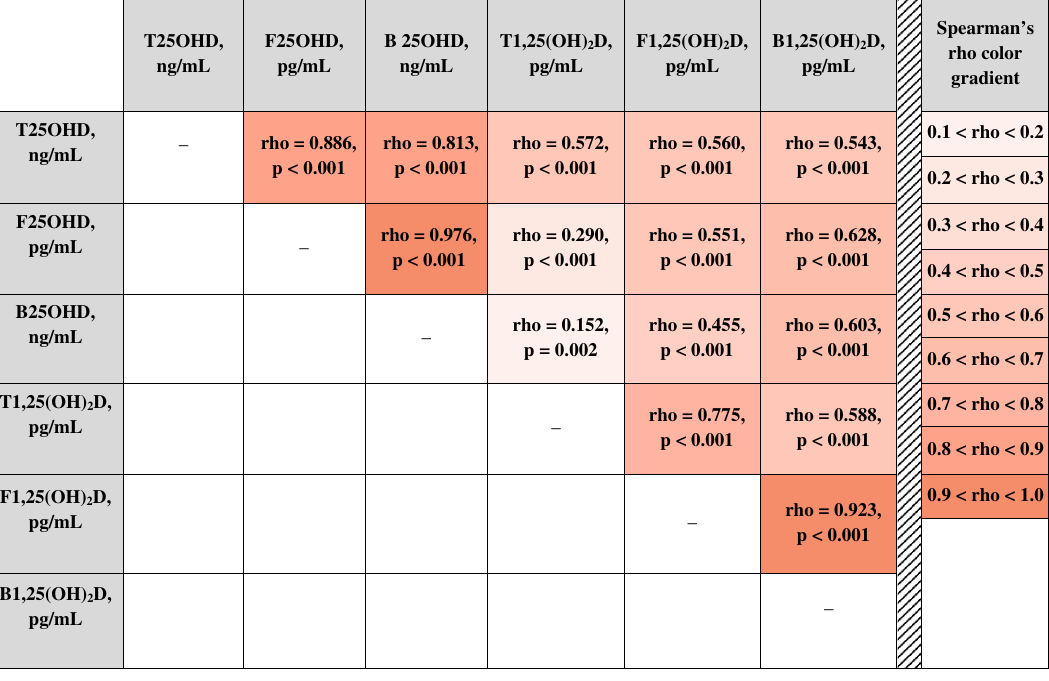
Table 2. Interrelations between 25OHD and 1,25(OH) 2 D isoforms. The correlation strength is defined by Spearman’s rank correlation coefficient rho. Abbreviations: B25OHD, bioavailable 25OHD; B1,25(OH) 2 D, bioavaialble 1,25(OH) 2 D; F25OHD, free 25OHD; F1,25(OH) 2 D, free 1,25(OH) 2 D; T25OHD, total 25OHD; T1,25(OH) 2 D, total 1,25(OH) 2